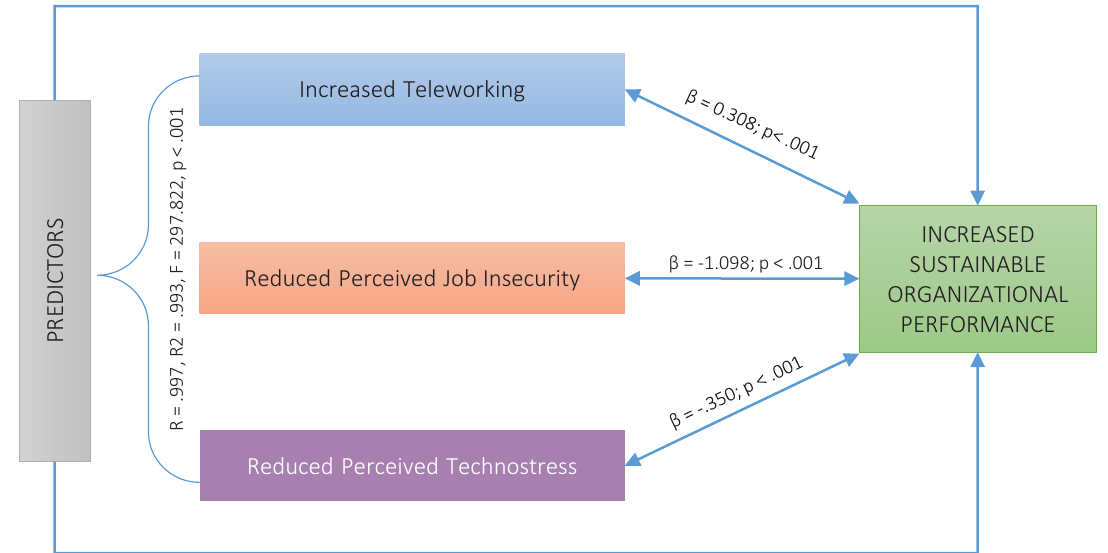
Figure 2. Practical model of effectually increasing and sustaining organizational performance of Nigeria’s businesses in the post-COVID-19